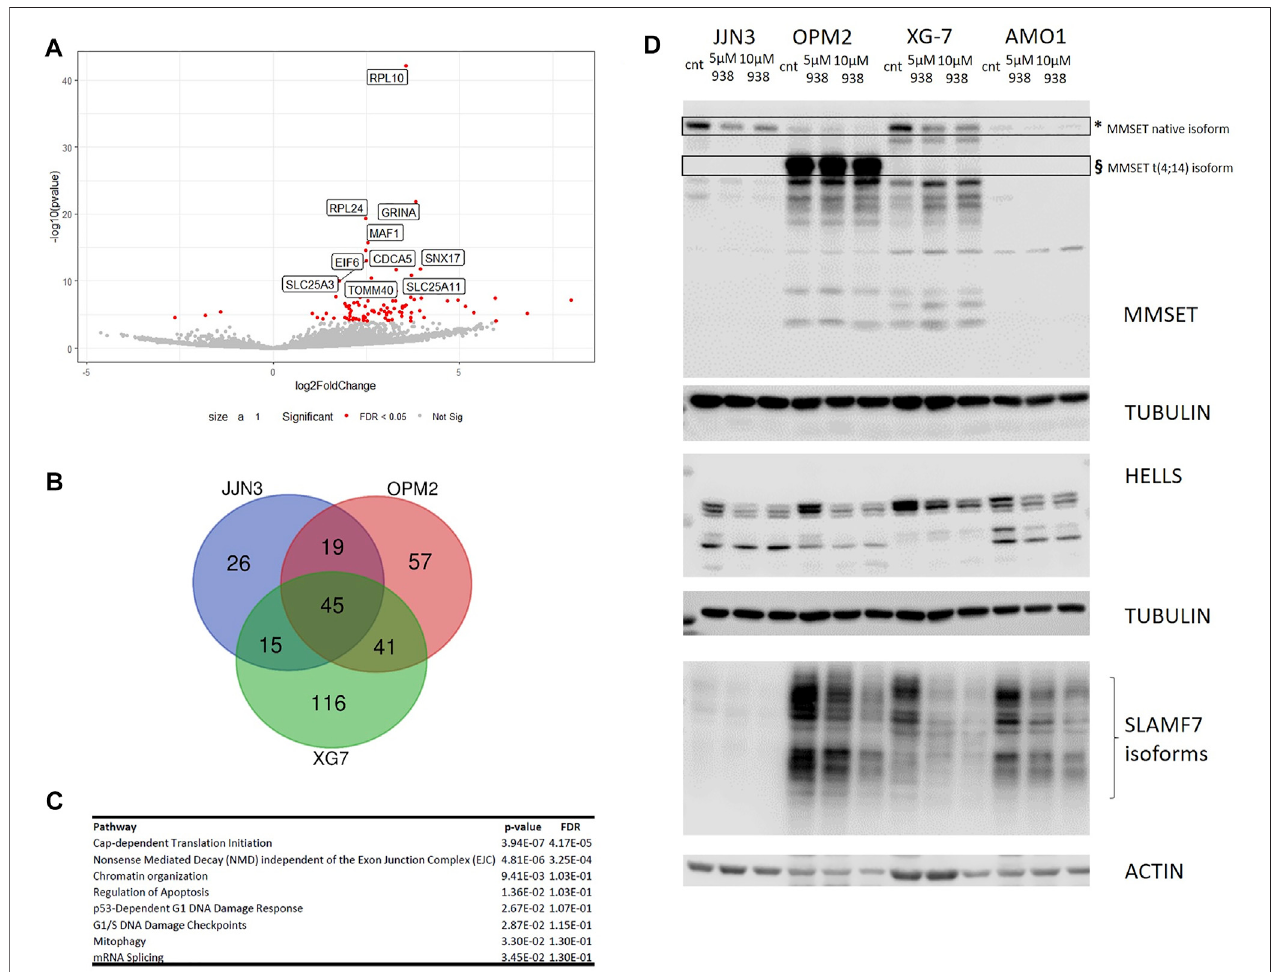
FIGURE 5 | (A) : Intron retention due to PRMT5 inhibition was evaluated by re-analysis of RNA-seq data (as described earlier) using IRFinder ( n = 2 for each conditionandpercellline).VolcanoplotshowsIRFinderoutputinJJN3cells,identifyingdifferentgenetargetsaffectedbyintronretention.OnlytheplotforJJN3isshown here, other plots are shown in the supplementary data. (B) : Venn diagram presentation of common genes affected by intron retention ( n = 2 × 2 per HMCL/treatment condition). A set of 45 common affected genes were identi fi ed. Samples were analysed per cell line type to account for cell type speci fi c effects. (C) : Reactome enrichment analysis was subsequently performed using the 45 common genes. Selected pathways that were deregulated are shown. (D) : Western blot analysis of identi fi ed targets MMSET/WHSC1 HELLS and SLAMF7in JJN3, OPM2, XG7 and AMO1 cells. ForMMSET, * depicts the wild type MMSET isoform where § depicts the aberrant MMSET protein affected by t (4; 14), which is present in OPM2 cells. Tubulin and actin were used as loading control. One experiment representative of 3 experiments performed is shown ( n =